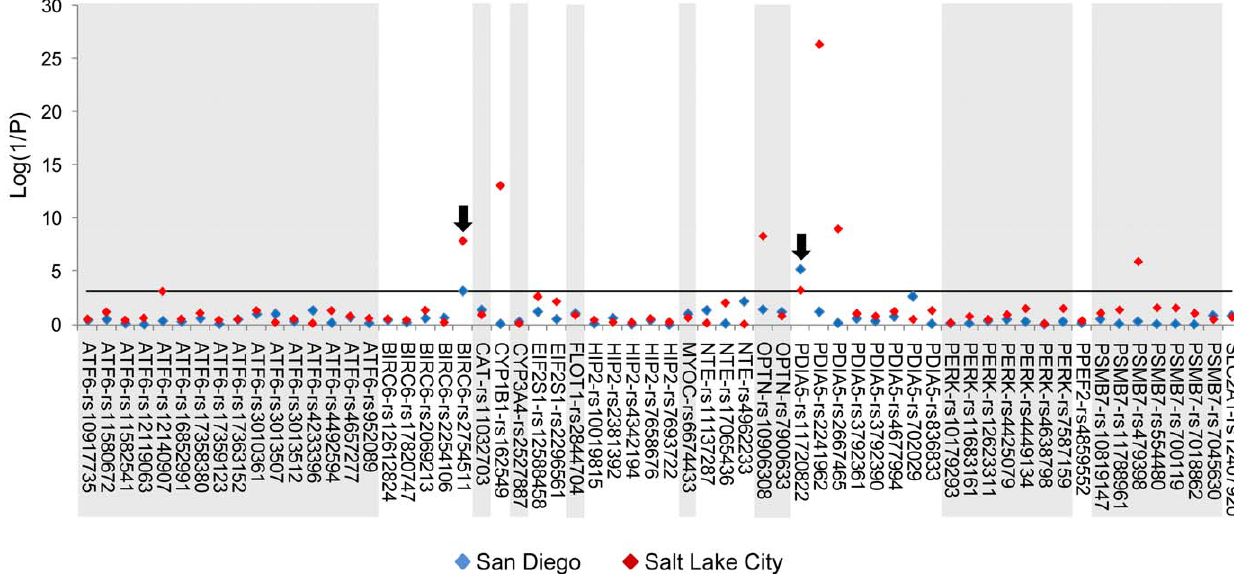
Figure 1. Association between POAG and candidate gene tagging rsSNPs. The graph shows the genotypic P-values (Log(1/P); y-axis) from likelihood ratio Chi-squared tests of associations with candidate gene SNPs (x-axis) from 2 populations (San Diego (blue) and Salt Lake City (red)). The black arrows indicate SNPs that were significant in both the San Diego and Salt Lake City cohorts. The black horizontal line indicates the Bonferroni adjusted P-value